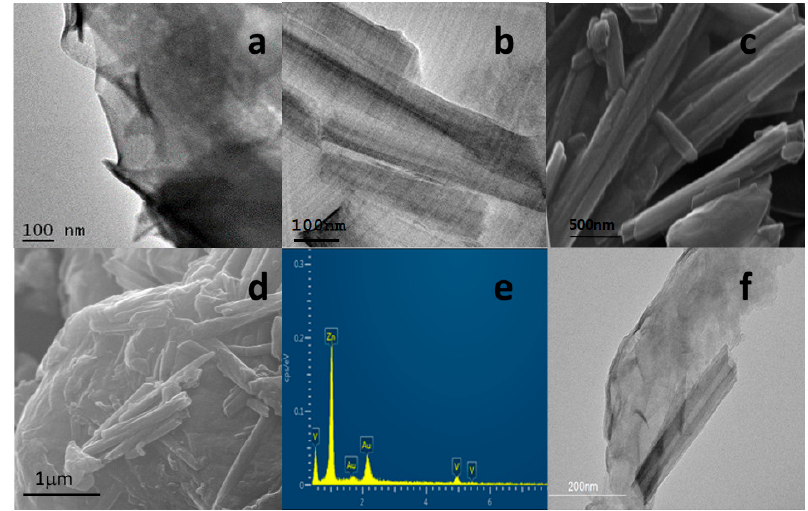
Figure 2. ( a ) TEM image of ZnO (stearic acid), ( b ) TEM image of VOx ‐ NTs, ( c ) SEM image of VOx ‐ NTs, ( d ) SEM image of nanocomposite ZnO (stearic acid)/VOx ‐ NTs, ( e ) EDS of nanocomposite and ( f ) TEM image of nanocomposite ZnO (stearic acid)/VOx ‐ NTs.